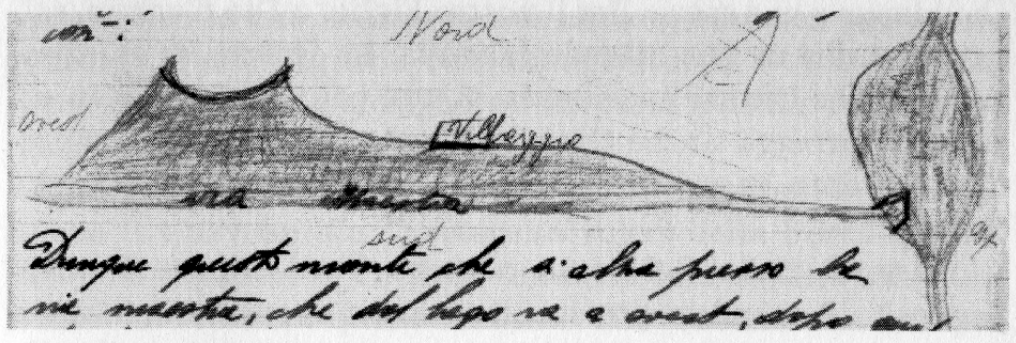
Figure 2. Maria Valtorta draws (169.1) the geography of the “Speech of the Mountain”. Actually, it was delivered not in a single day but in seven days, in March 32 AD, from Sunday 2 to Saturday 8. These dates have been estimated by the second Author. From right to left: Lake of Genezareth, the road ( via maestra ) climbing to the West ( Ovest ) up to the tableland with the small village ( Villaggio ), the Horns of Hattin. Maria Valtorta does not know their names. None of the EMV characters mention them. The correspondence of Figure 2 with the modern photographs of the area shown in Figures 3 and 4 is very striking. In Figure 3 the horns appear distinctly.